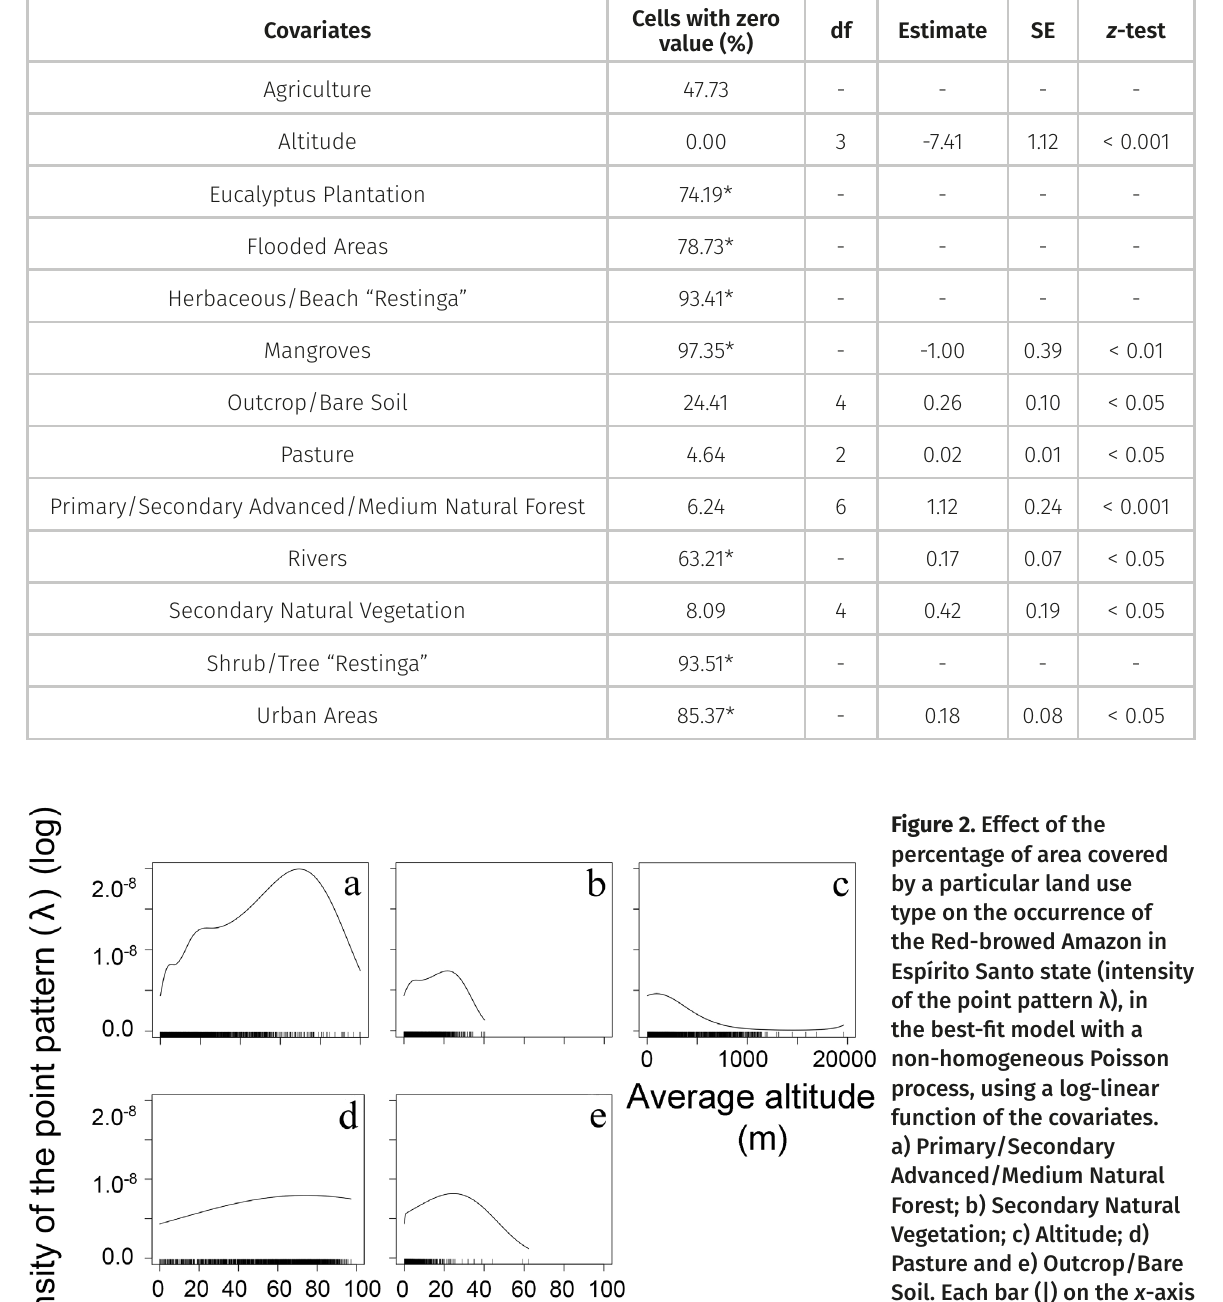
Table I. Covariates with the percentage of cells with zero value and statistics obtained from the non-homogeneous Poisson process (with intensity of the point pattern λ a log-linear function of the covariates) for the covariates included in the best-fit model that explain the Red-browed Amazon occurrence in the Espírito Santo state during 2004-2006. An asterisk indicates land use types treated as dichotomous (present or absent). df = degrees of freedom; SE = standard error; z -test = Statistical significance obtained with the z -test; - = values not calculated (covariates that did not enter in the final multivariate model).